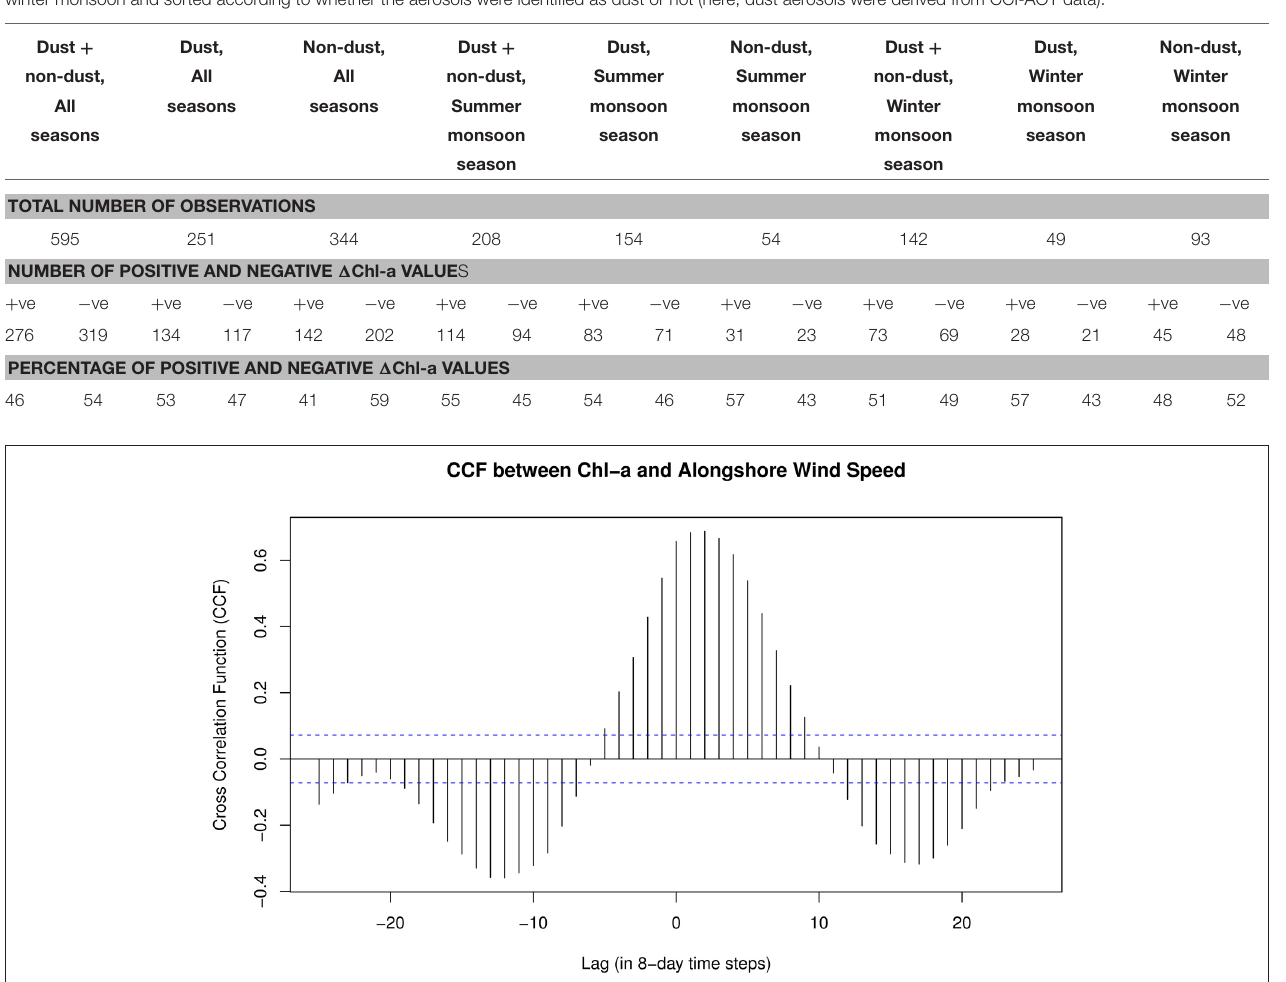
TABLE 3 | The number of observations with enhancements in Chl-a ( + ve 1 Chl-a) or reductions in Chl-a ( − ve 1 Chl-a), for all data, and for the summer monsoon, for the winter monsoon and sorted according to whether the aerosols were identified as dust or not (here, dust aerosols were derived from CCI-AOT data).